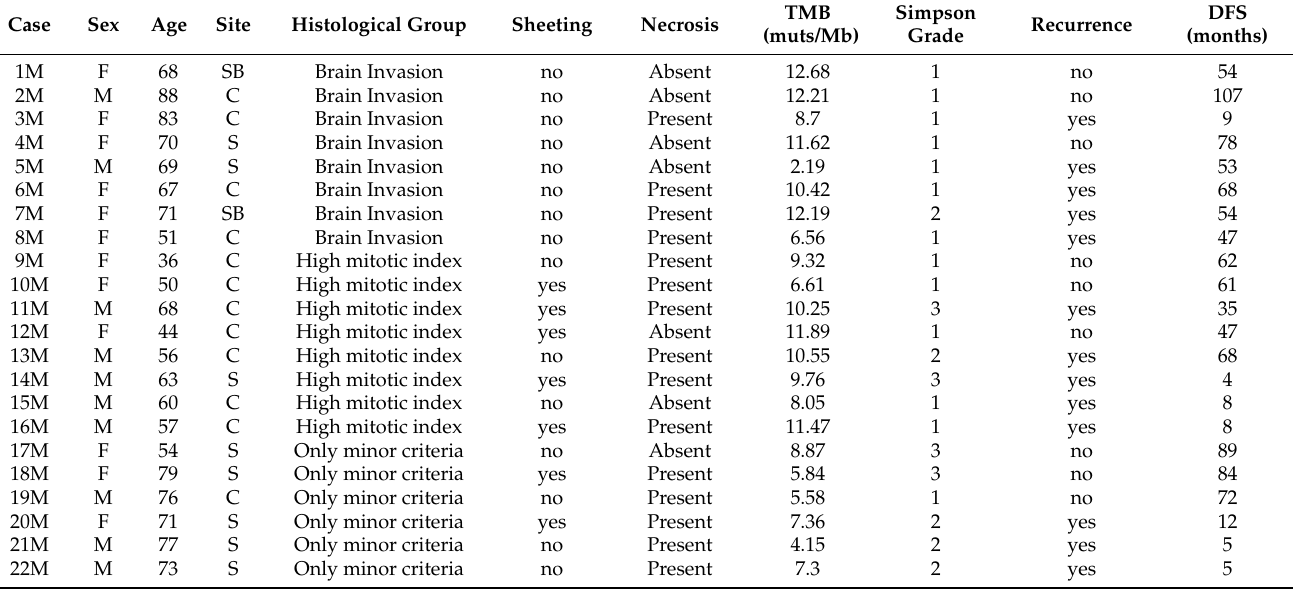
Table 1. Clinical-pathological features and tumor mutational burden (TMB) of 22 atypical meningiomas.